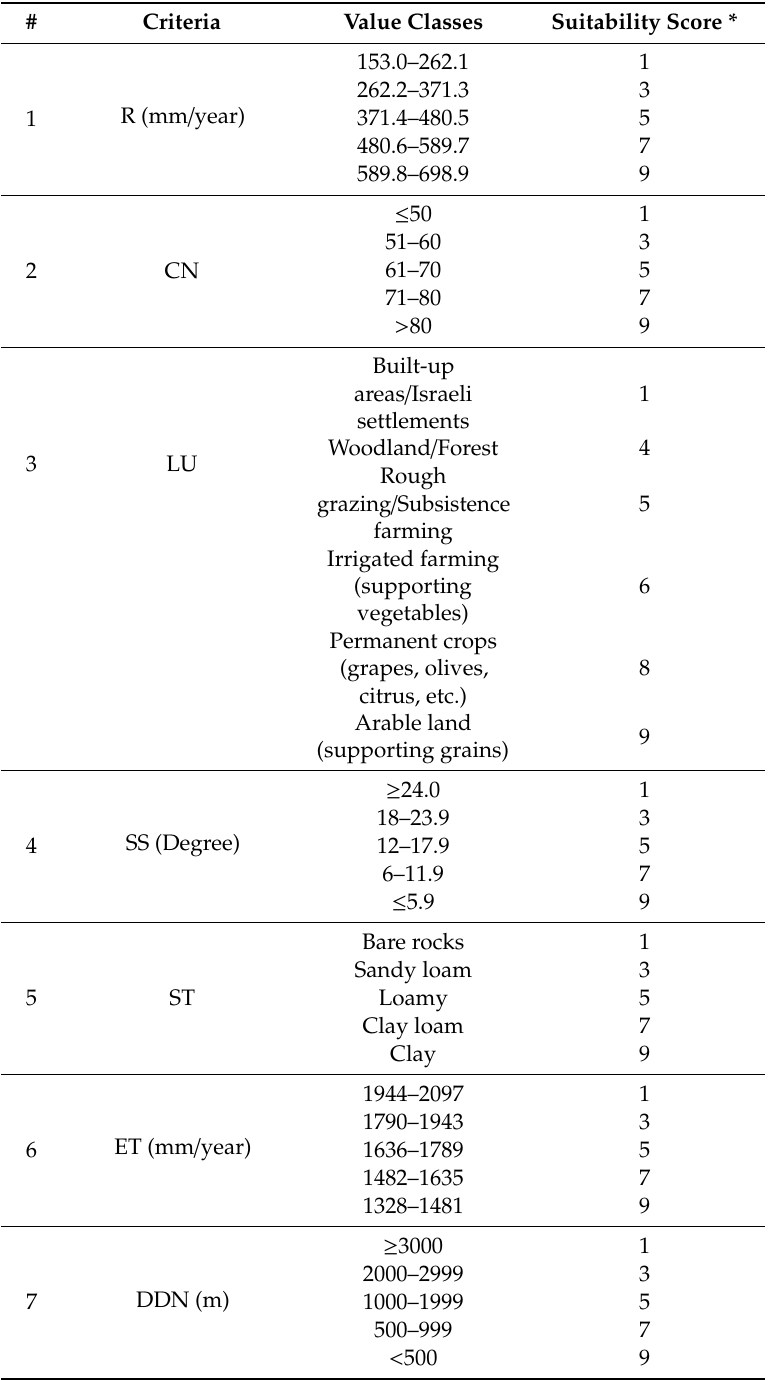
Table 6. ARWHS scores assigned for the value classes for the West Bank case